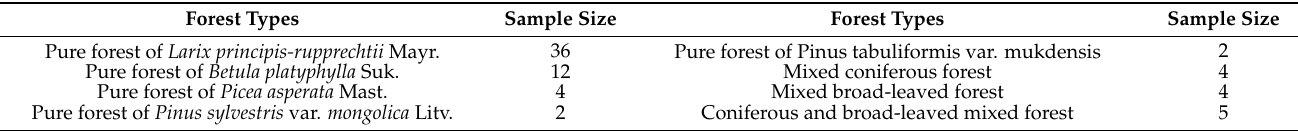
Figure 2. Forest conditions in the study area and the sample plot survey. ( a ) The diamond-shaped sample with an area of 0.06 ha. Moreover, ( b , c ) show the determination of sample plots and measuring heights of trees using ultrasonic height gauge. Furthermore, ( d – h ) show forest conditions in the study area, where: ( d ) is the pure forest of Larix principis-rupprechtii Mayr.; ( e ) is the pure forest of Pinus sylvestris var. mongolica Litv.; ( f ) is the mixed forest of Larix principis-rupprechtii Mayr. and Betula platyphylla Suk.; ( g ) is the pure forest of Picea asperata Mast.; and ( h ) is the broadleaf mixed forest. Table 1. Forest types and the collected random sample